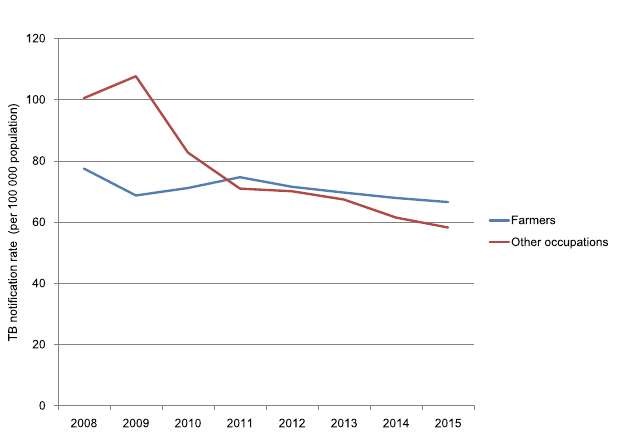
Figure 2. The TB notification rate in different age groups from 2008 to 2015.